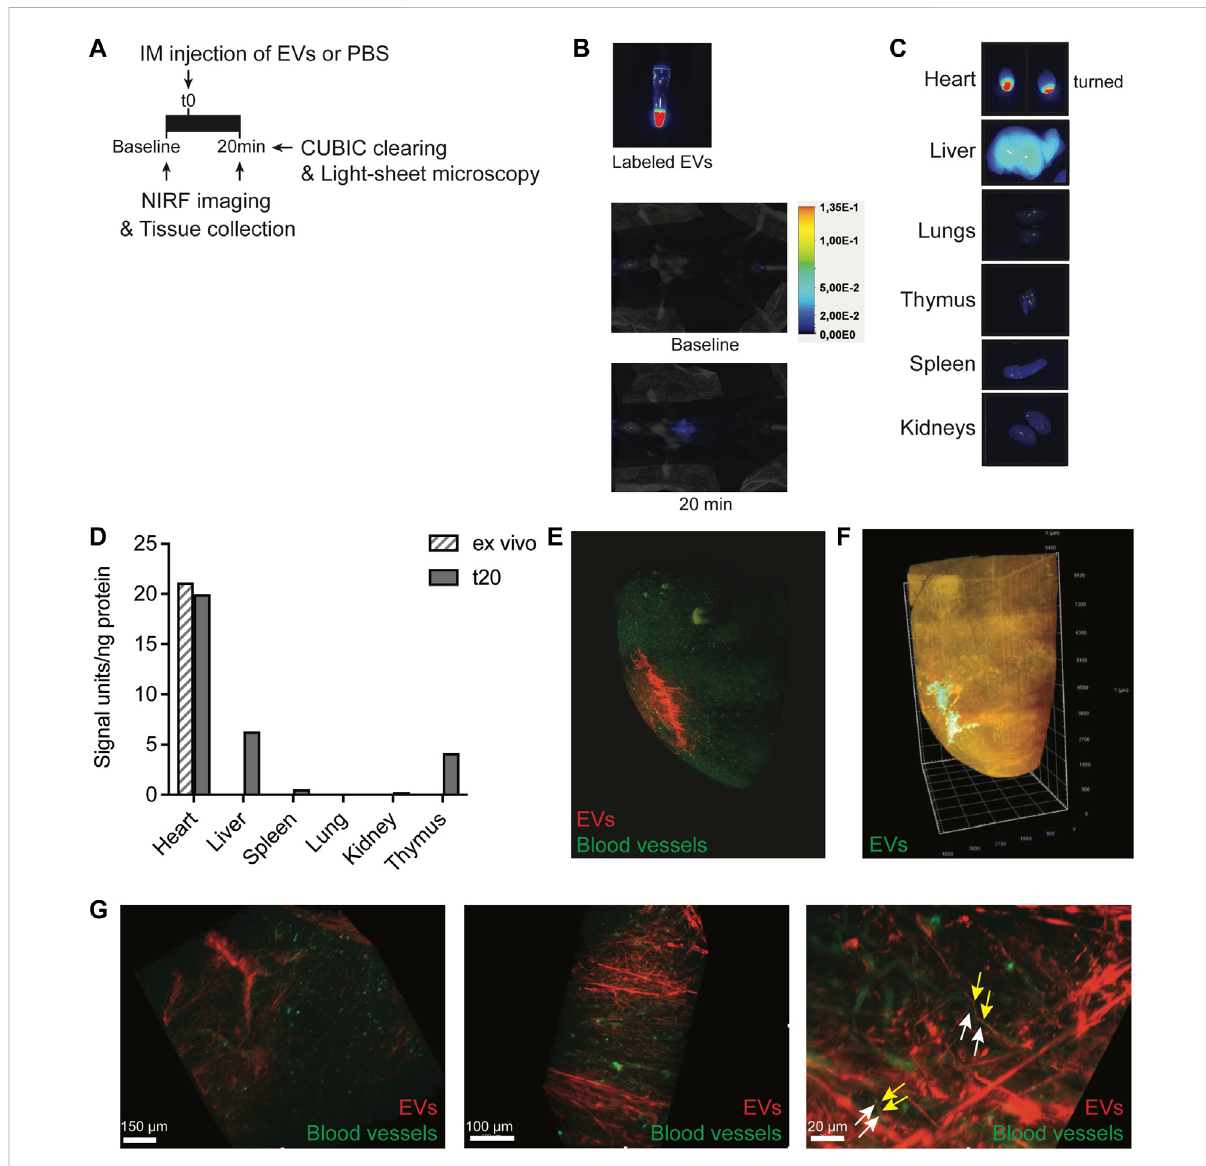
FIGURE 2 Short-term EV biodistribution after intramyocardial injection. (A) Schematic overview of EV administration and near-infrared (NIRF) imaging directlyorat20 minafterintramyocardialinjection(IM)of5 μ L EVsintheleftventricle. (B) NIRFimagestakenfromtheEppendorfcontaininglabeled EVsandlivinganimalatbaselineand20 minafterintramyocardialEVadministration. (C) NIRFimagesofindividualorganscollectedaftertermination. Uncut images are included in Supplementary Figure S11. (D) Quanti fi cation of fl uorescence (800 nm) per ng protein in organ lysates as compared to organ background. An ex vivo heart injected with 5 μ L EVs was included as control. (E,F) Snap-shots of 3D fl uorescent images of the heart injected with (E) 2.5 × 10 10 or (F) 1.75 × 10 10 AlexaFluor647 NHS ester-labeled EVs, generated after CUBIC tissue clearing and subsequent light- sheet fl uorescent microscopy. Images represent two independent experiments. (E) Heart was perfused with Lectin-FITC to stain blood vessels before tissue collection. Snapshots at higher magni fi cation are displayed in (G) . Arrows indicate no co-localization of (yellow) EVs and (white) blood